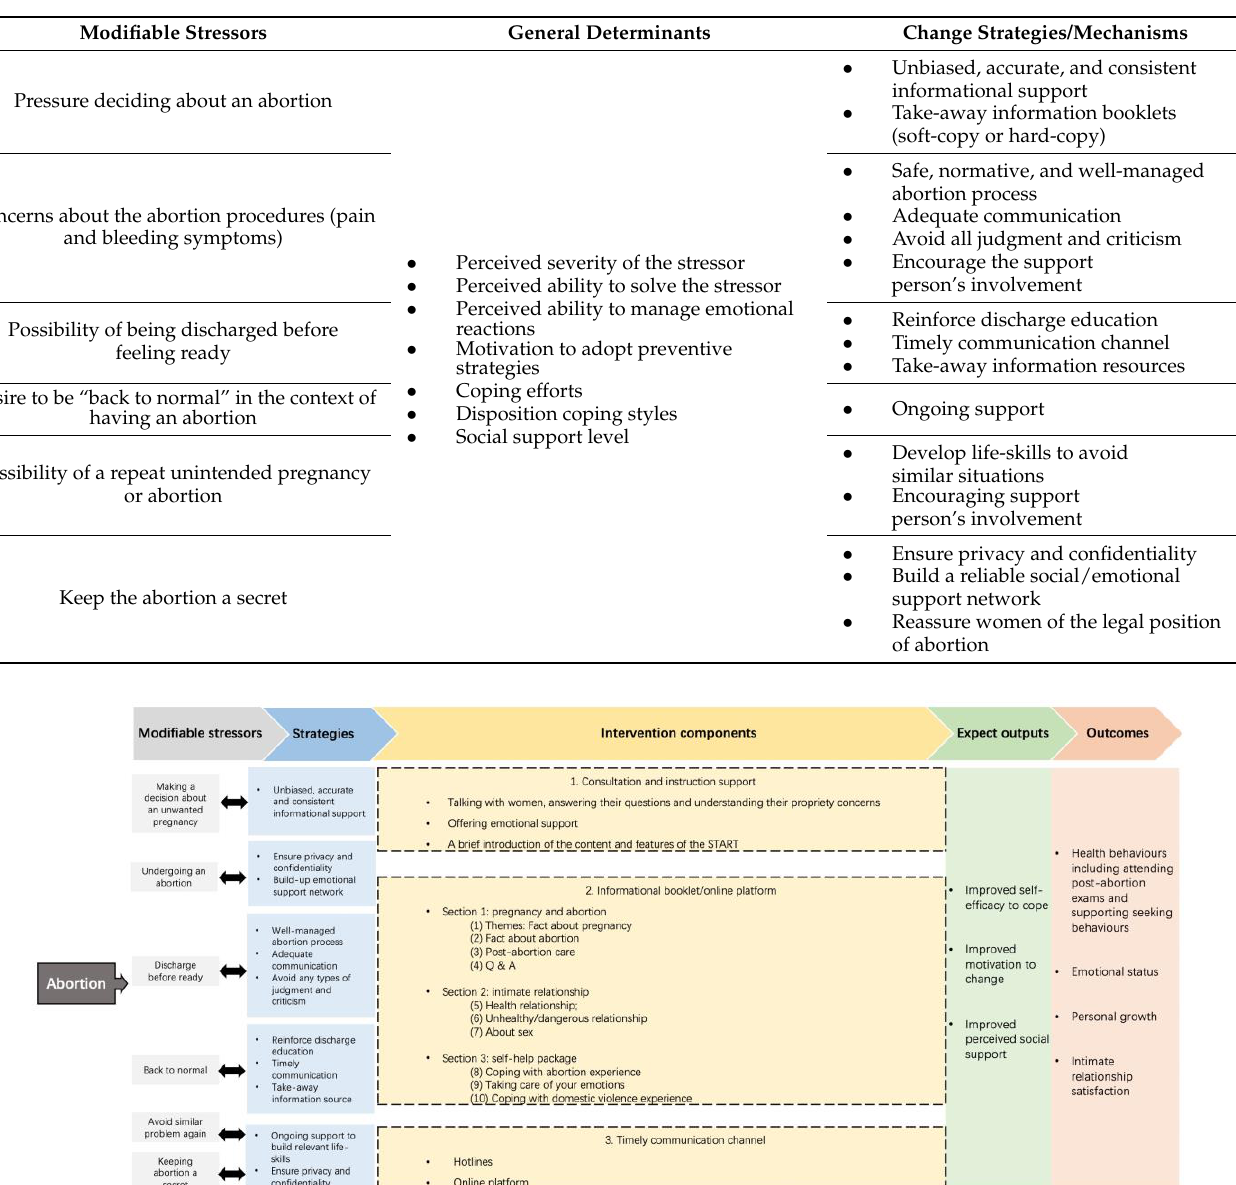
Table 3. Change mechanisms for the START intervention.